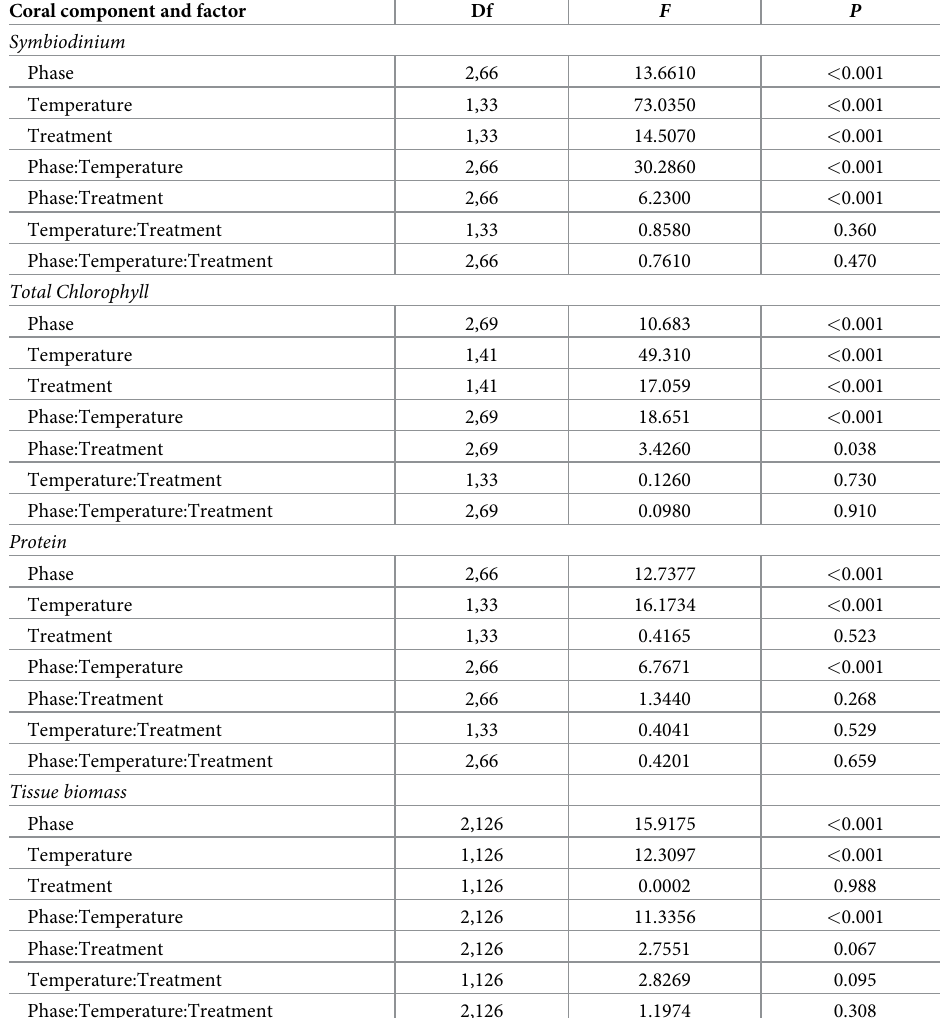
Table 2. Linear mixed effect model of the effect of phase, temperature, and fish presence ( D . aruanus ) on experi- mental P . damicornis colonies for (i) Symbiodinium density, (ii) total chlorophyll density, (iii) total proteins (iv) and tissue biomass (as part of the manipulative thermal bleaching experiment), where coral colony was included as a random